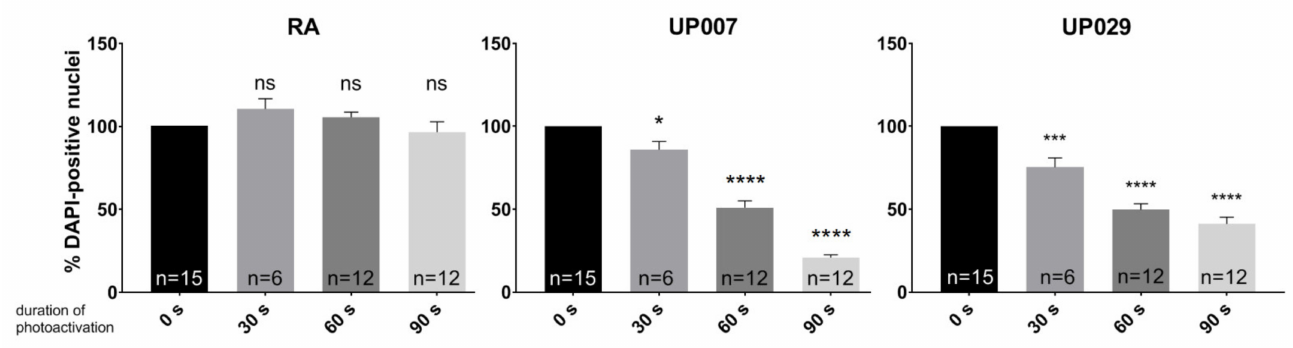
Figure 4. Dependence of TMRM-PDT (100 nM; 0 s, 30 s, 60 s, 90 s; 1.4 mW/mm 2 )) on the duration of illumination. N is the total number of repeats from 4 independent experiments. (*) p value < 0.05, (***) p value < 0.001, (****) p value < 0.0001. ns—not